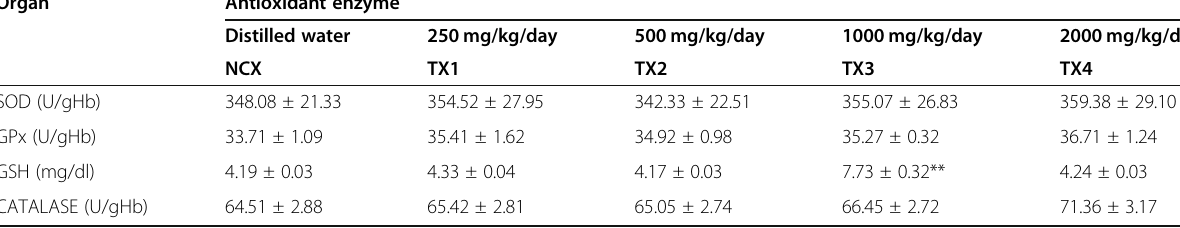
Table 10 Effect of polyherbal combination (PHC) on antioxidant enzymes Organ